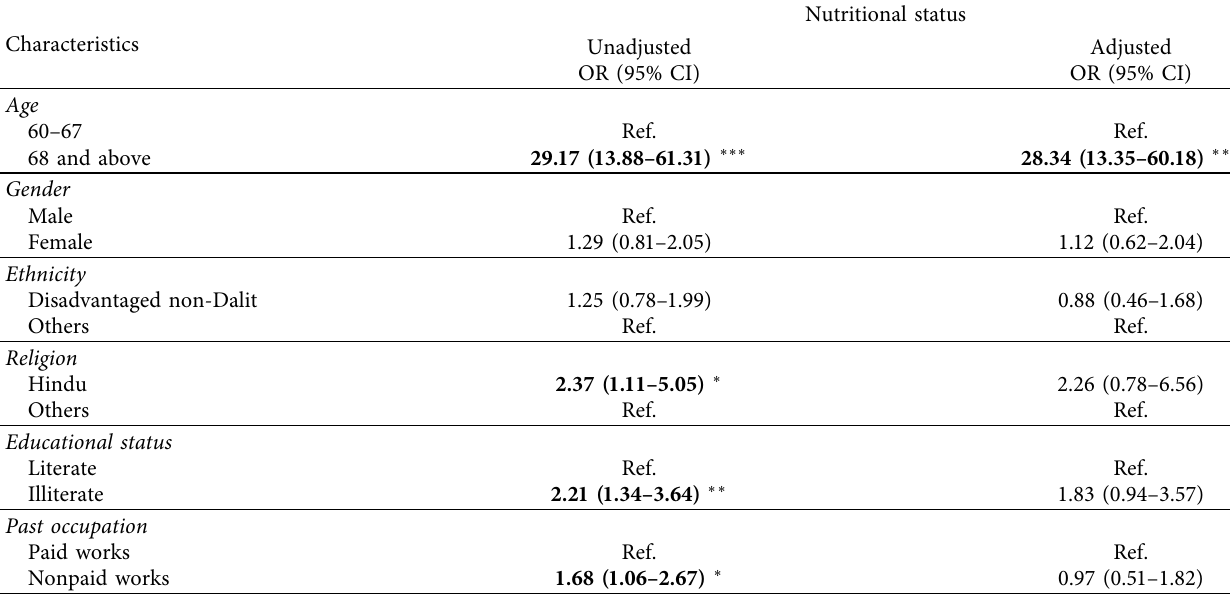
Table 3: Logistic regression on nutritional status with different variables.